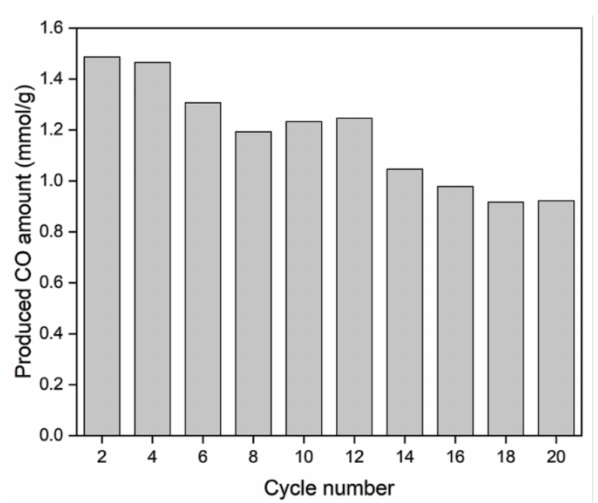
Figure 7. Cyclic performance of Co 3 O 4 -NiO@LSF during the long-term stability test.